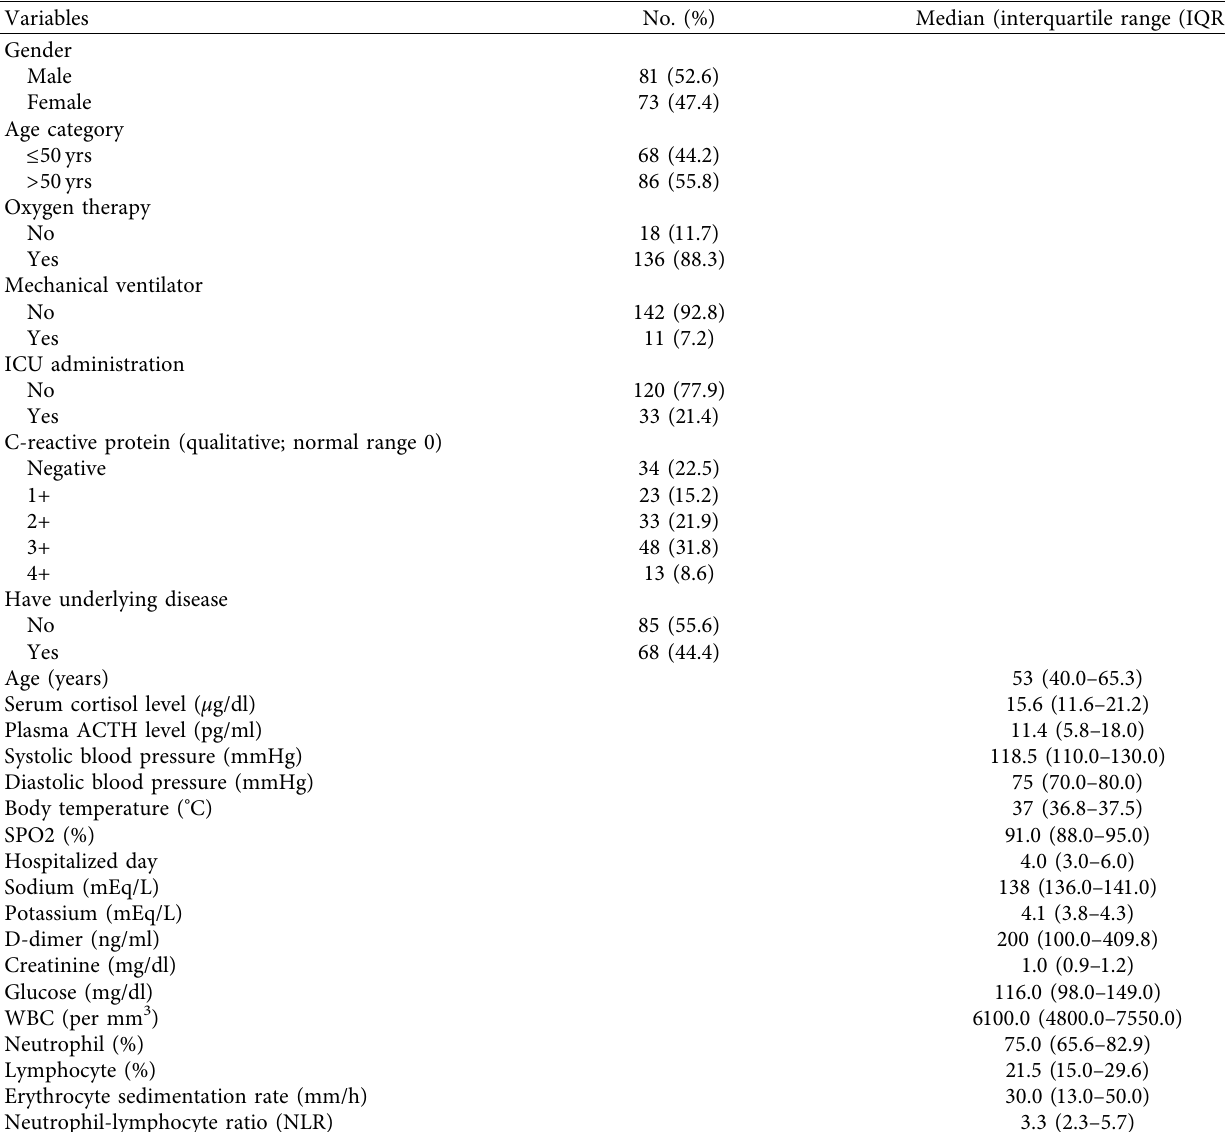
Table 1: Baseline characteristic of patients with